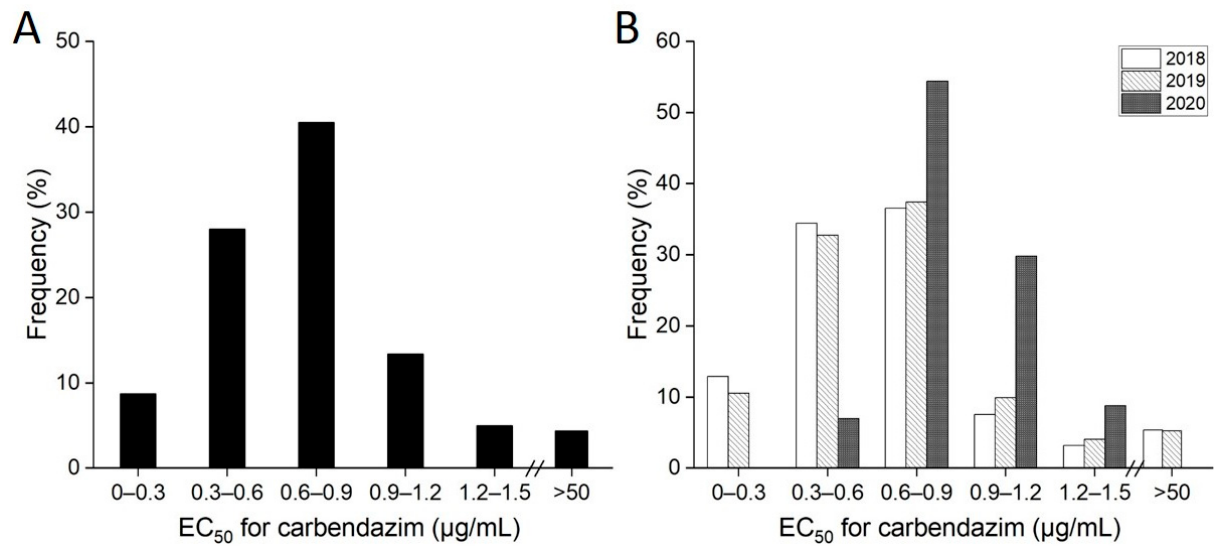
Figure 2. Frequency distribution of EC 50 values of Ustilaginoidea virens isolates to carbendazim. ( A ) Frequency distribution of EC 50 values of the total of 321 isolates. ( B ) Frequency distribution of EC 50 values of isolates collected from different years.